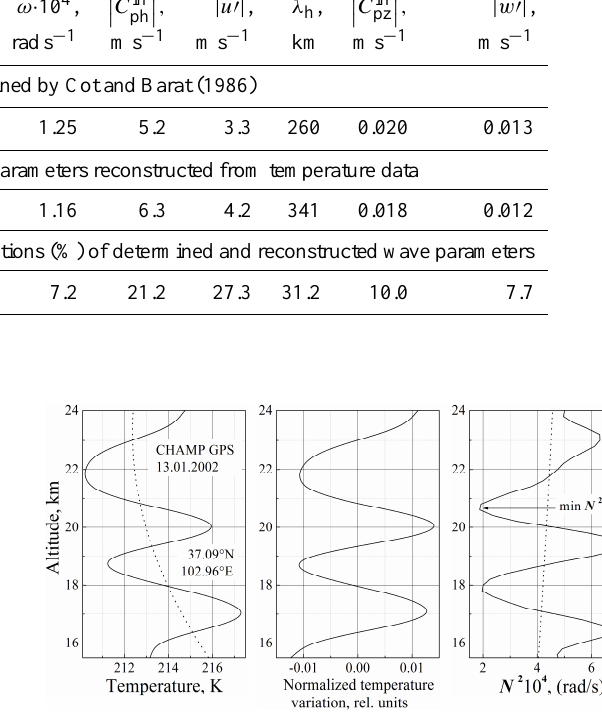
Fig. 1. Wavelike temperature oscillations in the middle latitudes of the Earth’s atmosphere observed from the vertical temperature profile retrieved from the CHAMP GPS radio occultation on 13 January 2002. In successive panels (from left to right), the vertical profiles of temperature (left panel), normalized temperature variation (middle panel), and Brunt-Vaisala frequency squared N 2 (right panel) are plotted. The solid lines are the raw data and dotted lines represent the corresponding background data. The vertical background profile was determined from the raw data by a least-squares cubic polynomial curve fit within the altitude interval of wave observations. The coordinates of sounded region and date of observation are indicated.